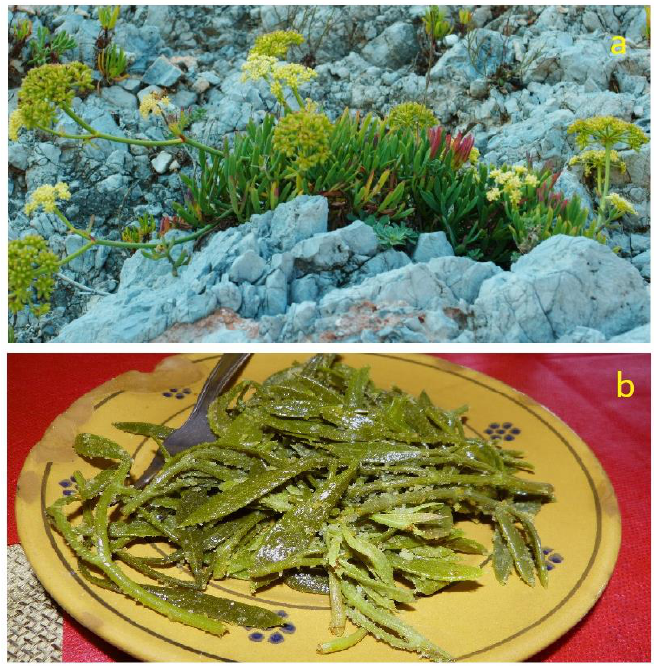
Figure 10. Crithmum maritimum ( a ); a typical side dish with sea fennel ( b ), consumed in Salento (Southern